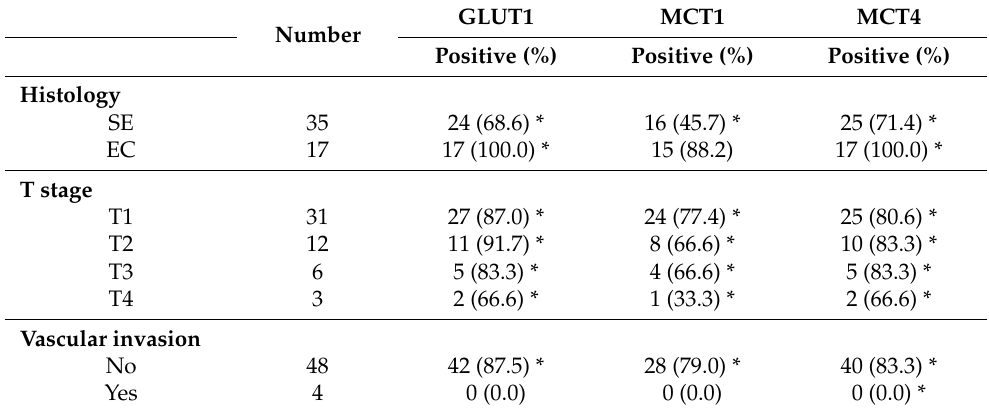
Table 5. Association of GLUT1, MCT1, and MCT4 expression with clinico-pathological parameters.